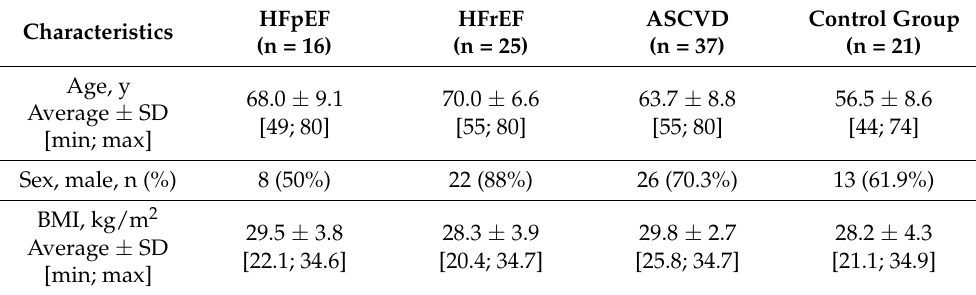
Table 5. Baseline characteristics of patients for qPCR analysis, PF extraction